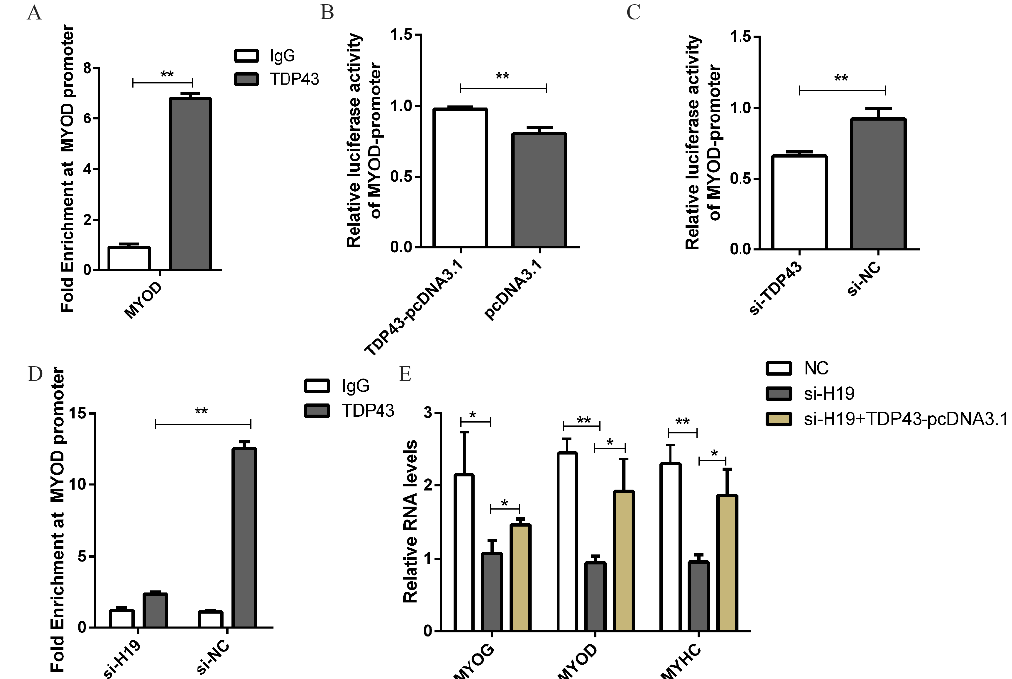
Figure 4. H19 regulates MYOD by a ff ecting the enrichment of TDP43 at the MYOD promoter. ( A ) Chromatin Immunoprecipitation (CHIP)qPCR results revealed that TDP43 bound to the MYOD